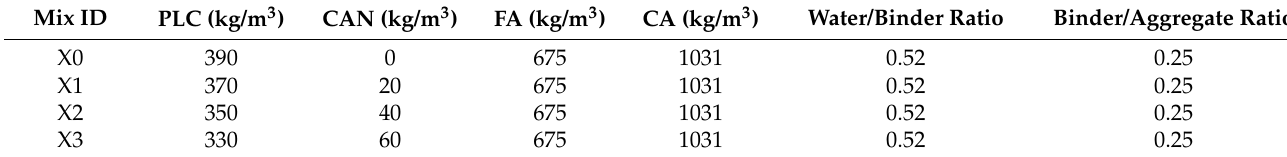
Table 3. Mix design proportions for M 30.